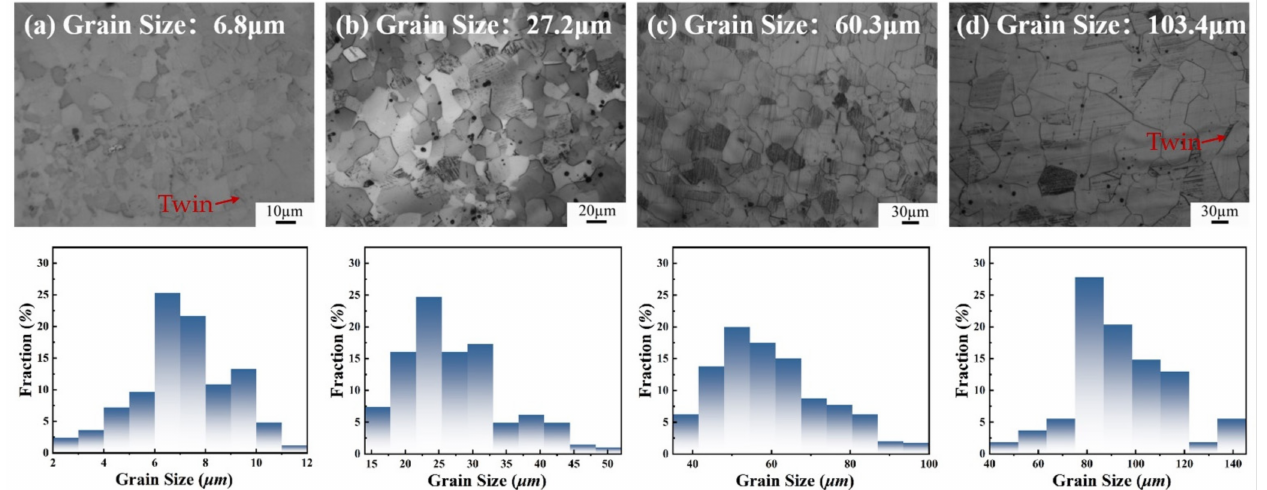
Figure 1. OM and grain size statistics of Fe-18Mn-1.3Al-0.6C steel after cold rolling and annealing